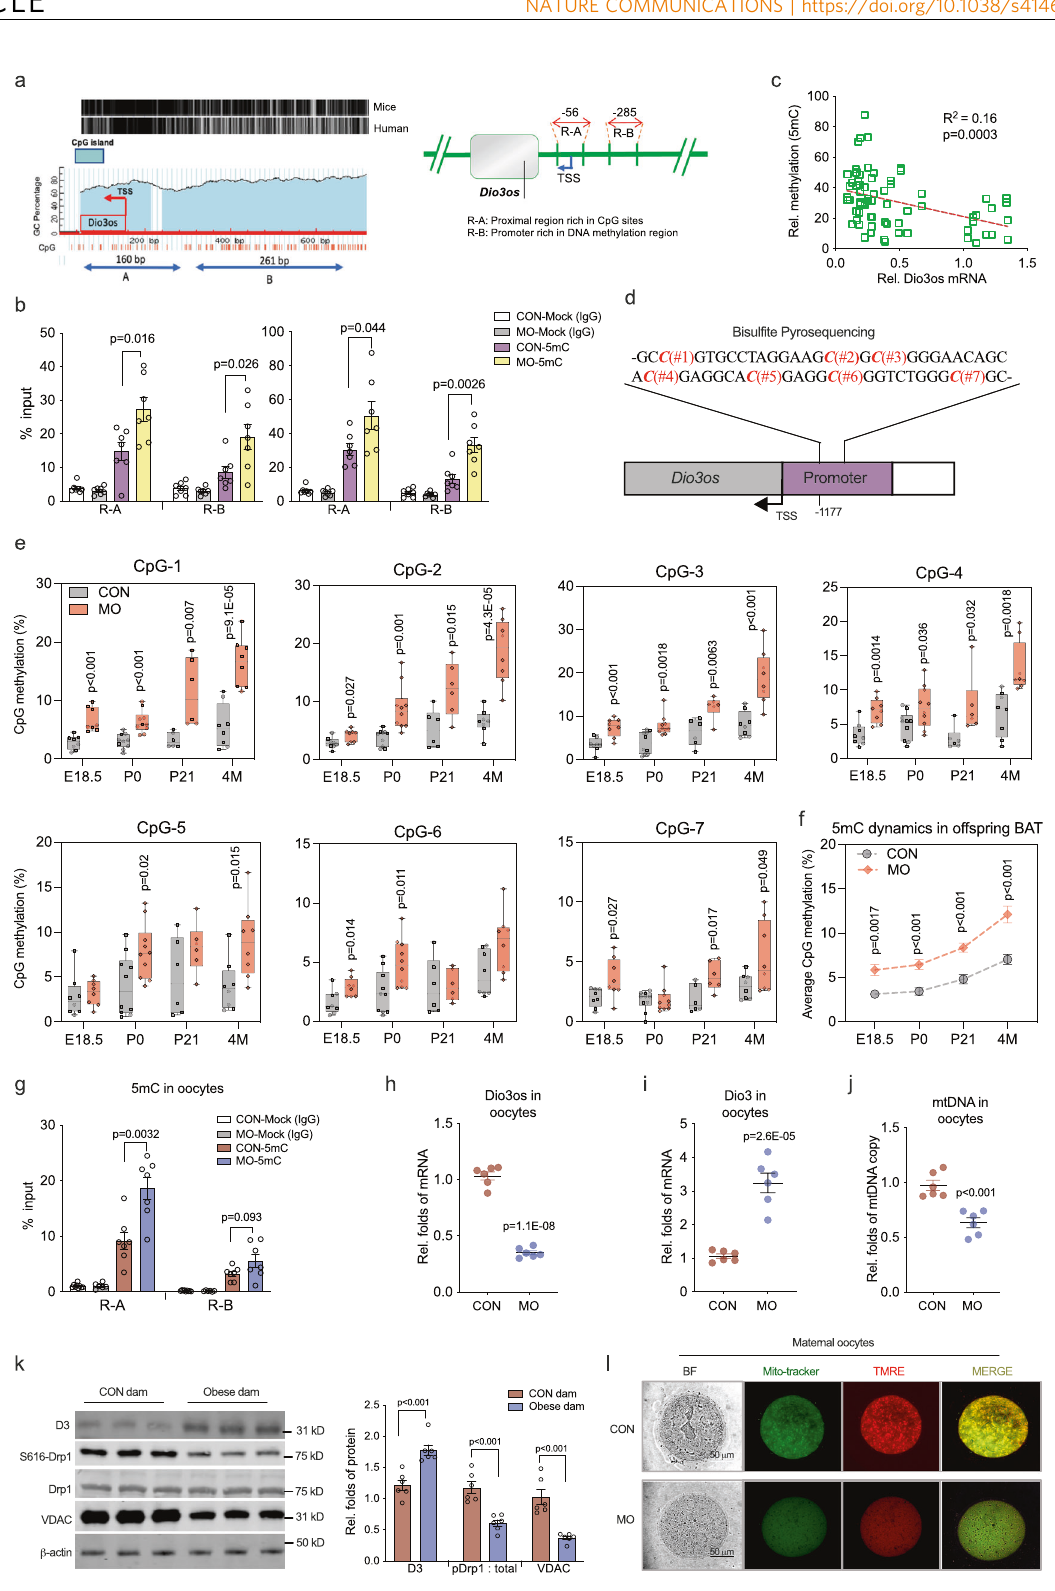
potential (Fig. 8l and Supplemental Fig. 12i). Taken together, these data revealed that MO increases promoter methylation of imprinted lncRNA Dio3os in oocytes, which persists in fetal and offspring BAT, potentially linking Dio3os suppression to the programming of metabolic dysfunctions in